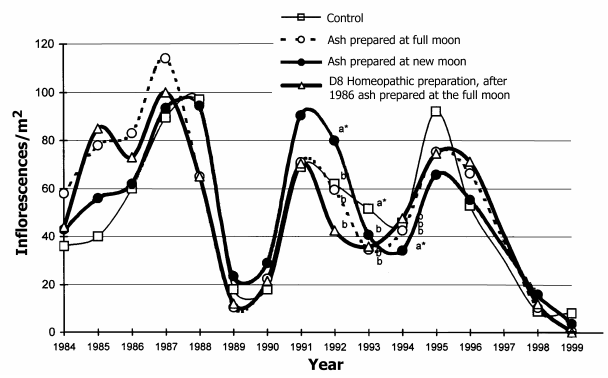
Figure 1. Results of a 17 year study (data was not collected for the first two years) on Taraxacum officinale occurrence after application of a BD seed pepper. Asterisks (*) indicate treatment/years where there was a significant difference in yield at the 0.5 level (Modified after [15], with